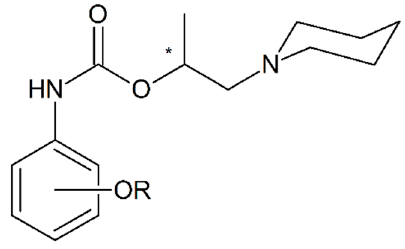
Figure 3. Derivatives of phenylcarbamic acid.